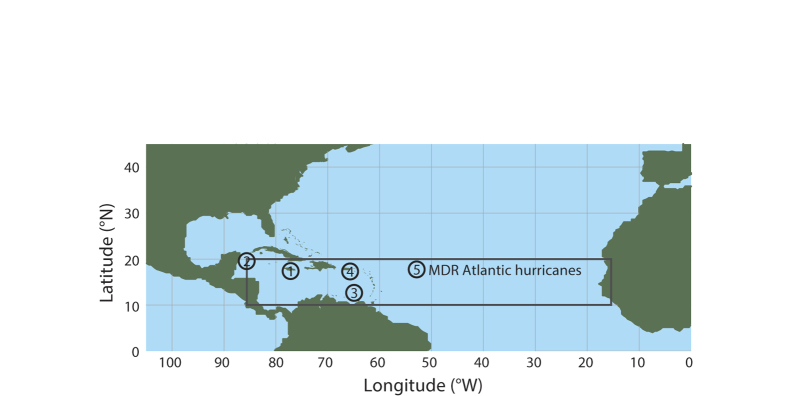
SST map of the tropical North Atlantic and Caribbean Regions.Map showing location of sites discussed in the text situated within the Main Developing Region (MDR; 10°–20°N; 15°–85°W) of Atlantic tropical cyclone activity. 1. Grape Tree Pond, Jamaica27; 2. Yucatan Peninsula, Mexico30; 3. Los Roques, Venezuela31; 4. SW Puerto Rico32 5. MDR. Map created by Suzanne Palmer using Adobe Illustrator CC 2014.1.0 Release.